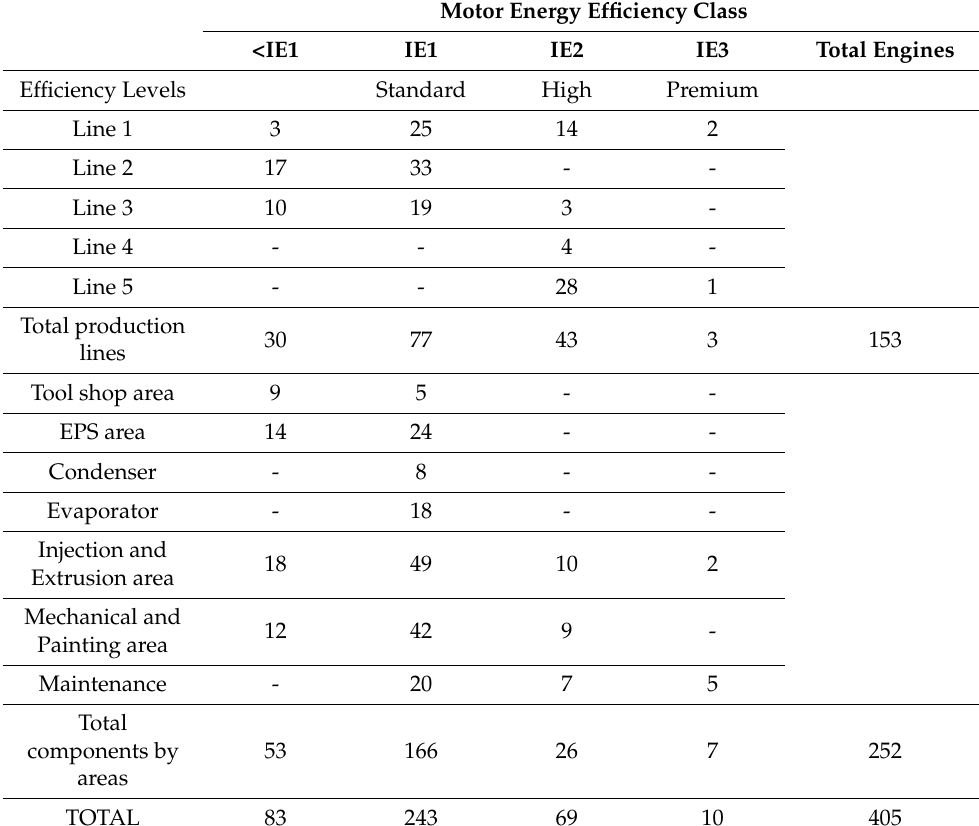
Table 4. Existing